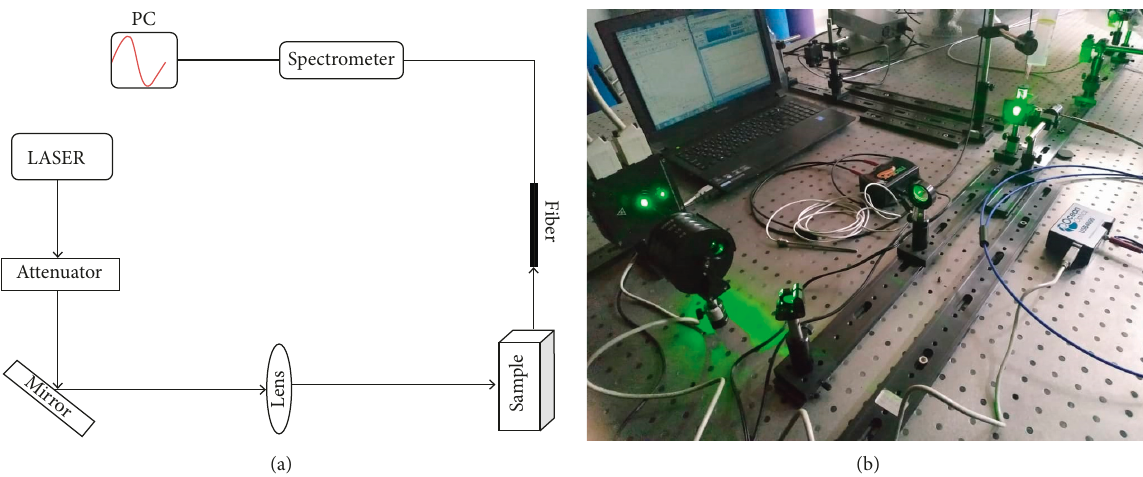
Figure 2: (a) Schematic layout of the optical setup used for recording fluorescence spectra resulting from BODIPY-520 photosensitizer in tissue-like optical phantoms. (b) Overview of the optical